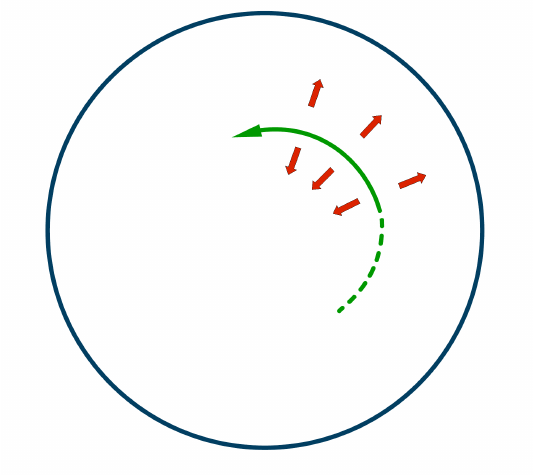
Figure 17: Illustration of the Hall viscosity in a circular droplet of electrons: a counter-clockwise stirring of the fluid in the bulk of the droplet causes an orthog- onal force (red arrows) (figure from [ 100 ]